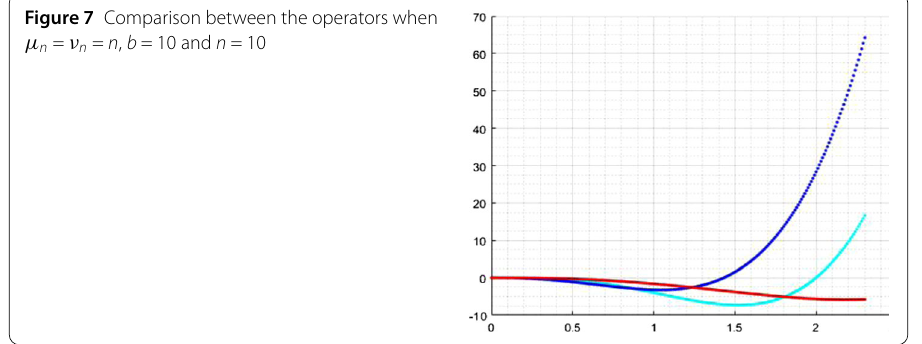
Figure 7 Comparison between the operators when μ n = ν n = n , b = 10 and n = 10